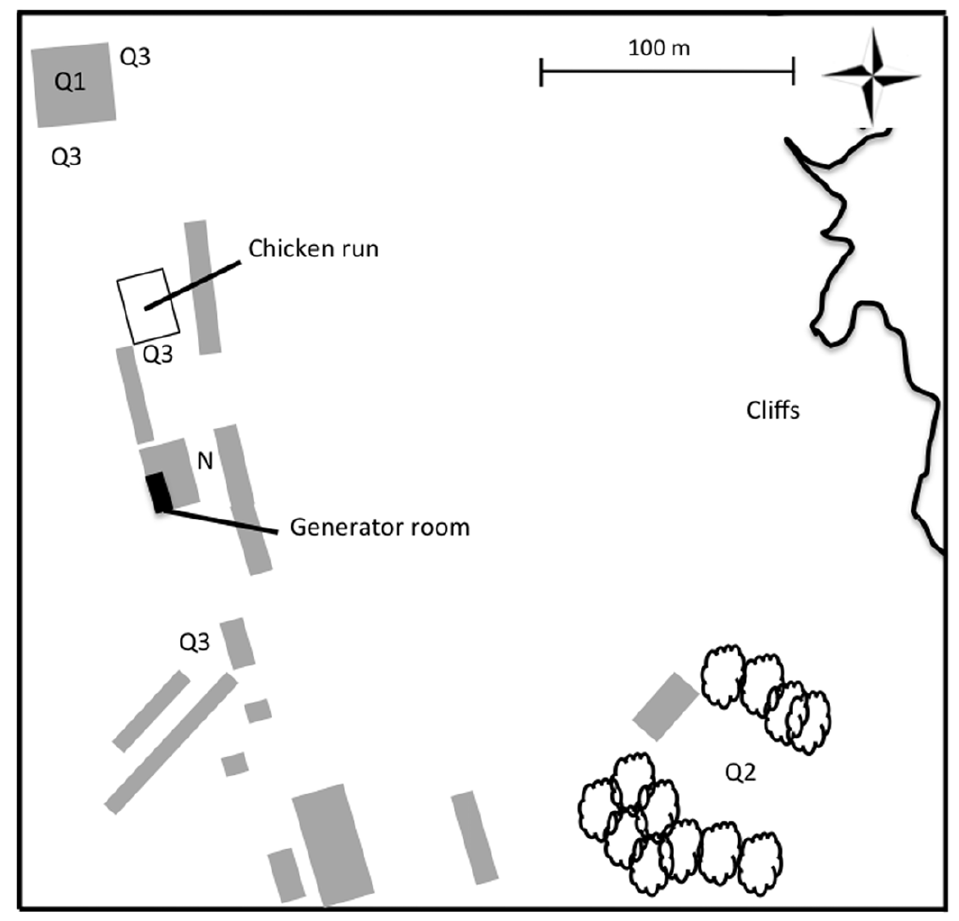
Figure 2. Locations of house sparrow nestboxes on Lundy Island. Grey boxes depict buildings.